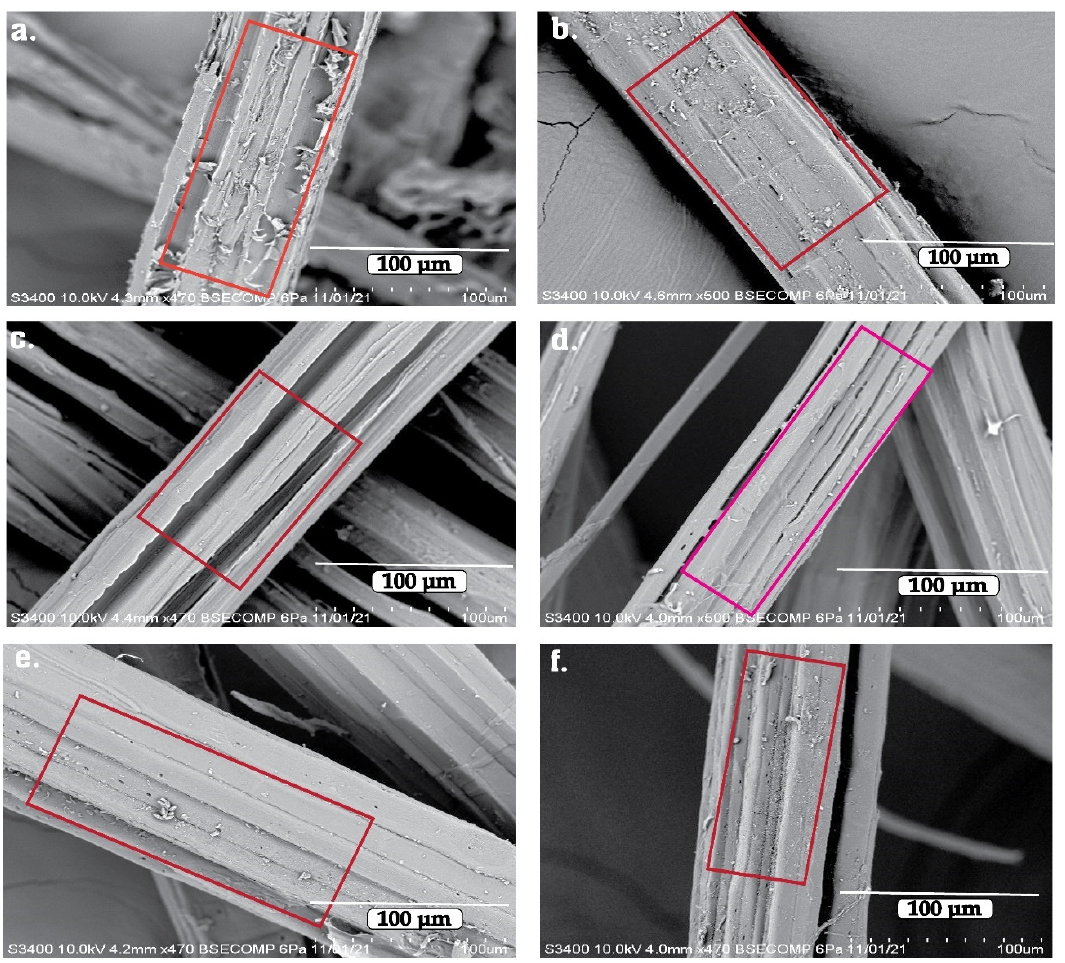
Figure 7. SEM images of retted kenaf fibers at a 100 µm magnification, showing the presence and absence of amounts of gummy substances on the fiber’s surfaces. ( a ) Uninoculated kenaf retted fiber with FW. ( b ) Uninoculated with SW. ( c ) APPB1 with SW. ( d ) APPB1 with FW. ( e ) APPB2 with SW. ( f ) APPB2 with FW.